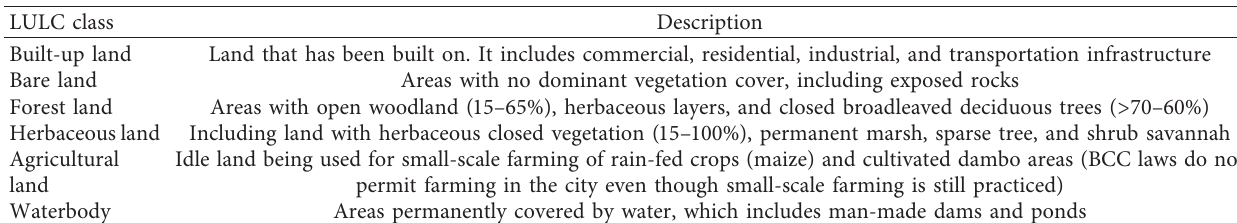
Figure 2: Flowchart of data processing Table 2: LULC class description.